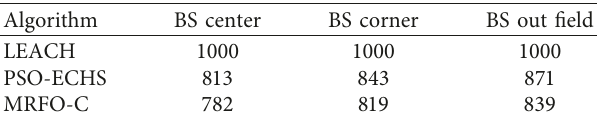
Table 5: Total energy consumption (in Joules) at round 5000 for 500-node network and 50 CHs.